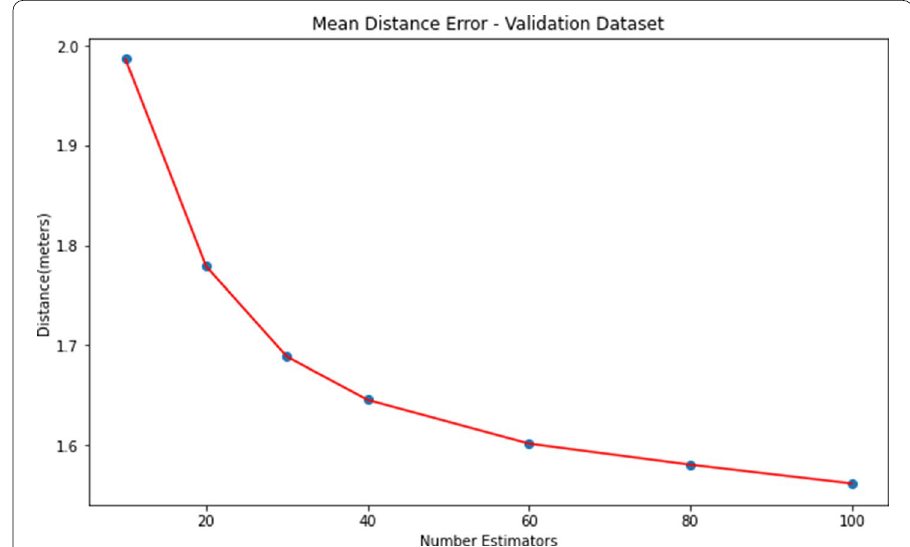
Fig. 10 Estimating model’s error on test dataset for random forest